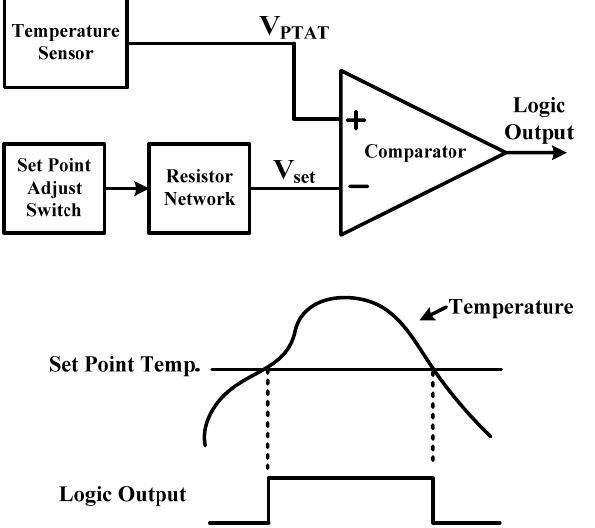
Figure 1. Simplified example of voltage-domain thermostat with logic